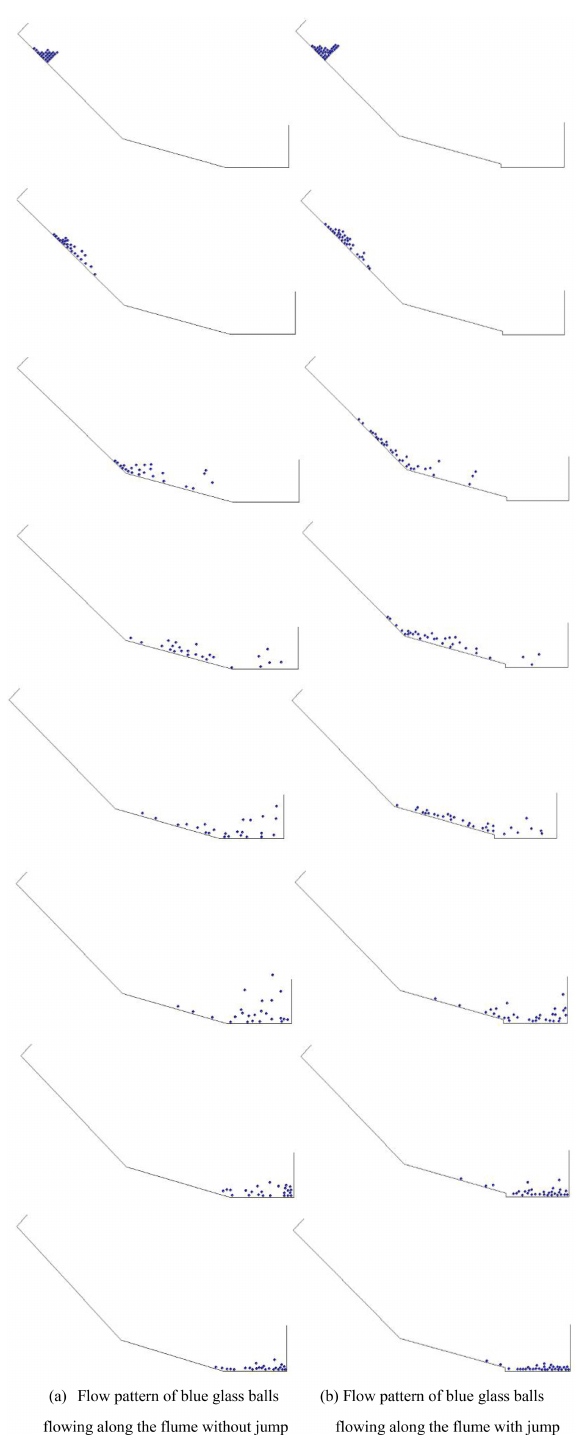
Figure 11. Flow pattern of blue glass balls flowing on the flume with or without a